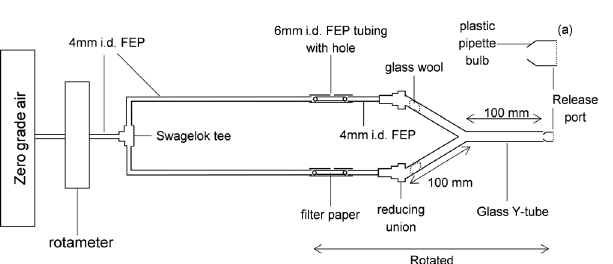
Figure 2. Y-tube olfactometer bioassay apparatus. A sand fly was introduced into the stem of the olfactometer using the release port shown in detail in (2a), and given time to respond to odours which had been introduced through the pierced hole onto the filter paper. Airflow was adjusted to 5 ml sec − 1 . After every ten replicates within a bioassay the Y-tube was rotated 180° around the